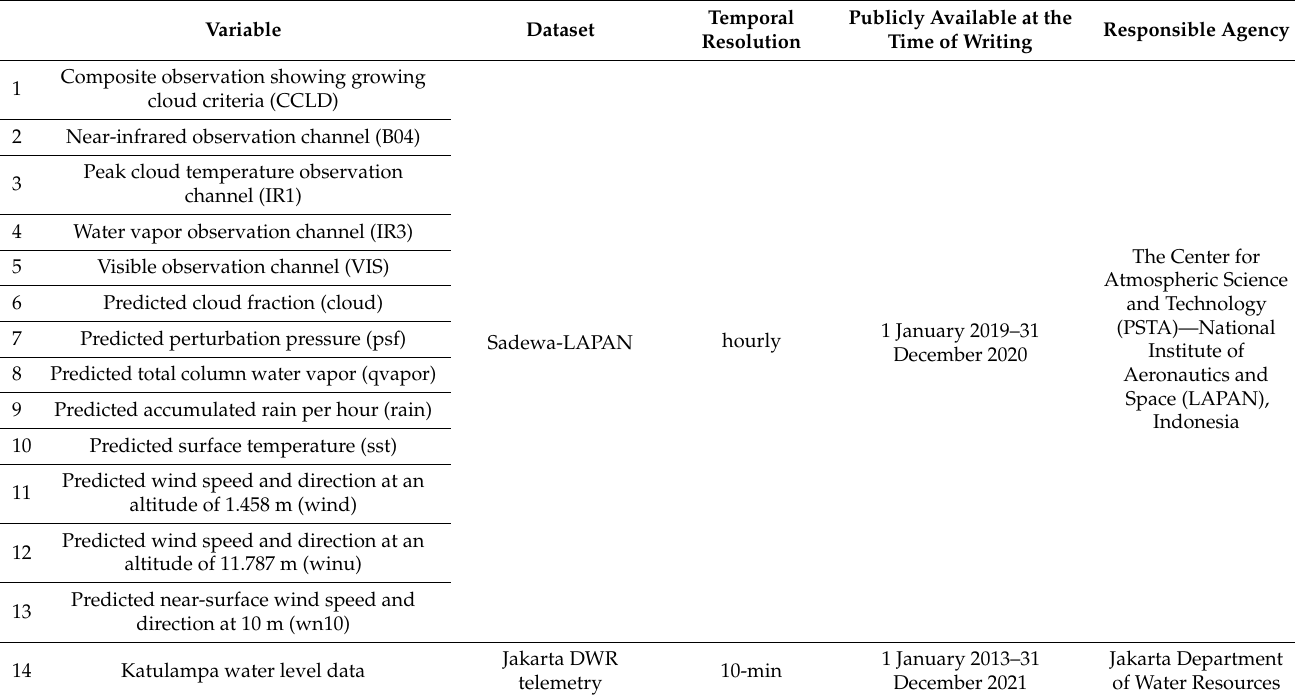
Table 2. Summary of the source dataset used in this